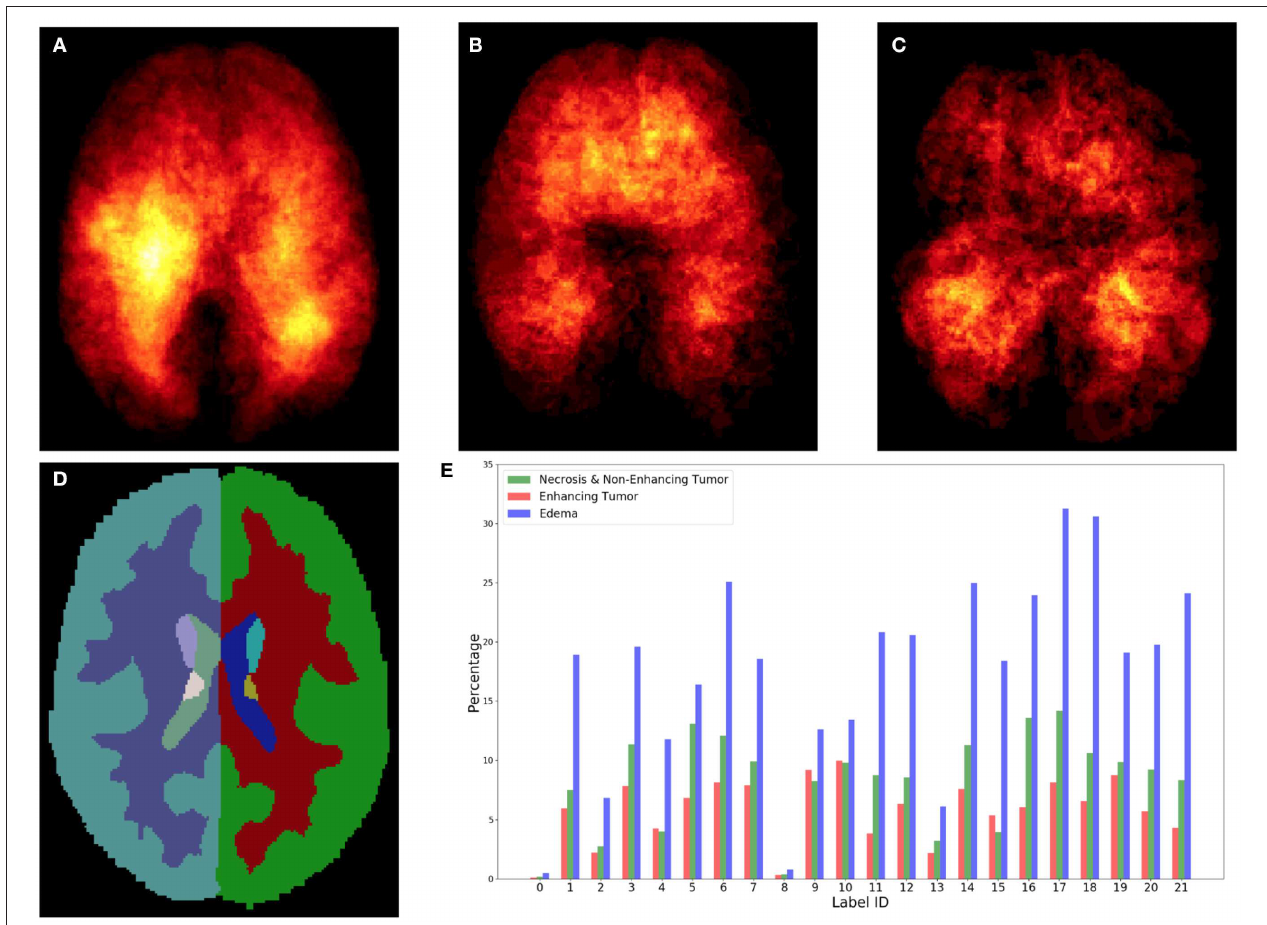
FIGURE 3 | Top row shows the heatmaps of different lesion sub-regions, (A) : edema, (B) : necrosis & non-enhancing tumor, and (C) : enhancing tumor, from 285 training subjects of BraTS 2018 in the MNI 152 1 mm space. The brighter (yellow) voxel represents higher value. (D) Shows Harvard-Oxford subcortical structural atlas ( Desikan et al., 2006), and (E) the percentage of brain lesion sub-regions observed in different parcellation regions of the Harvard-Oxford subcortical atlas from 285 training subjects of BraTS 2018. The x -axis indicates the brain parcellation label ID. Regions not covered by the Harvard-Oxford subcortical atlas are in label